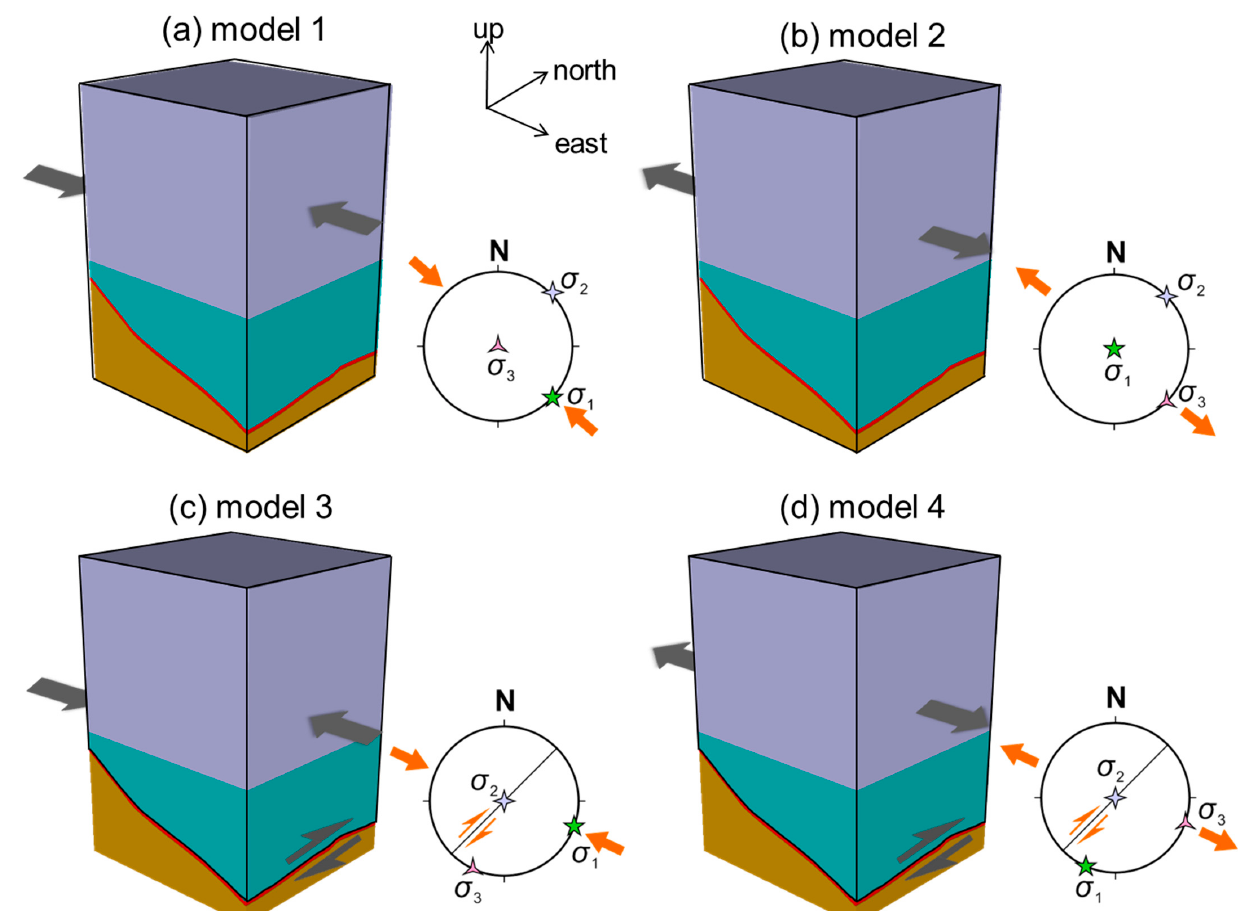
Figure 6. The setting of boundary conditions in the experiment and the kinematic states of models showing ( a ) compression in the NW–SE direction; ( b ) extension in the NW–SE direction; ( c ) extension in the NW–SE direction with dextral strike-slip; ( d ) extension in the NW–SE direction with dextral strike-slip. The paleostress directions for several models are also